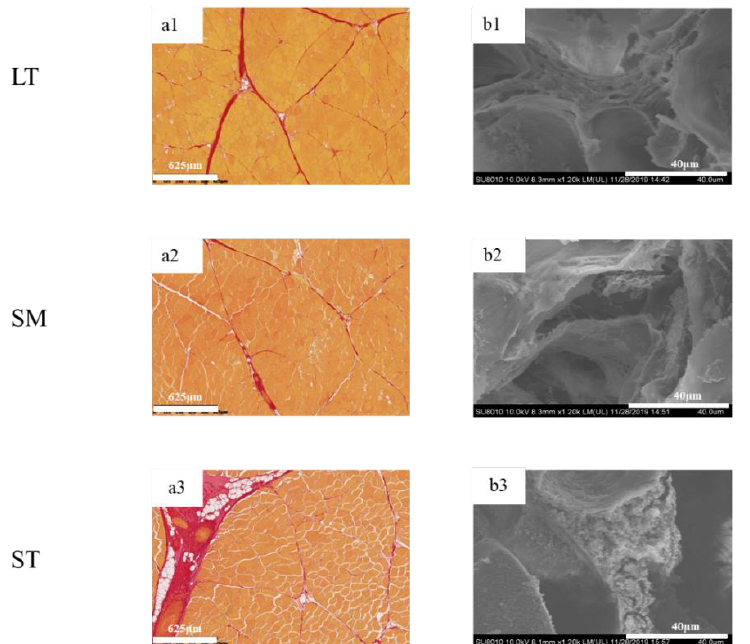
Figure 2. Histological microscopic images and SEM micrographs of porcine longissimus thoracis , semimembranosus and semitendinosus . ( a ) histological microscopic images; ( b ) SEM micrographs; 1, LT; 2, SM; 3, ST.